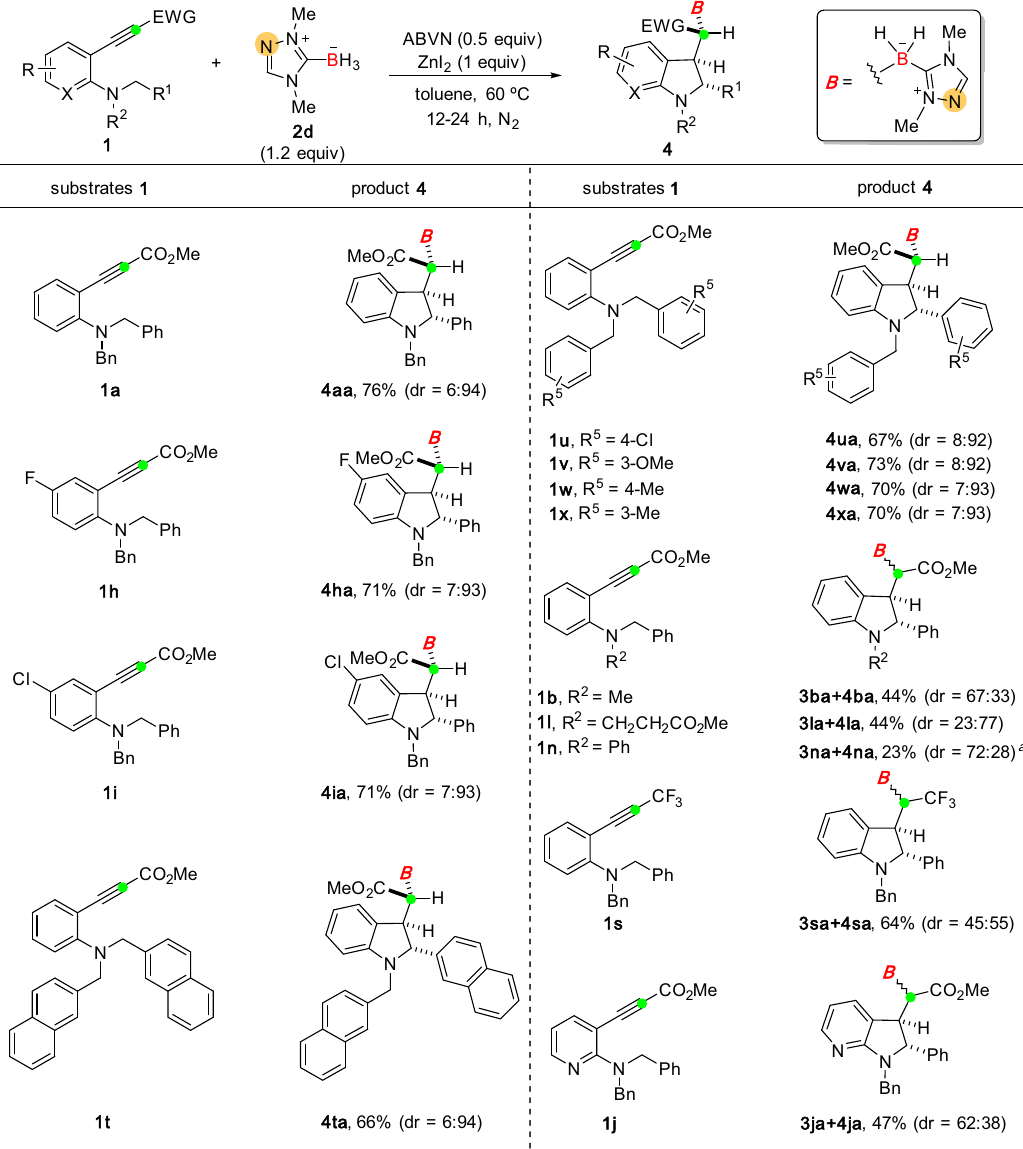
Fig. 3 NHC-BH 3 /ZnI 2 -controlled stereoselective synthesis of borylated molecules derived from RATC. Reactions were performed with substrate 1 (0.2 – 0.5 mmol), 2d (1.2 equiv), ABVN (0.5 equiv), and ZnI 2 (1 equiv) in toluene (2 – 3 mL) at 60 °C for 12 – 24 h. The yield is recorded for the combination